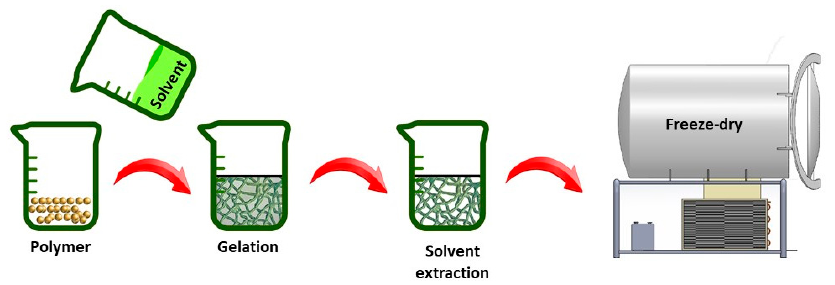
Figure 3. Illustration of thermally-induced phase separation (TIPS) production steps.